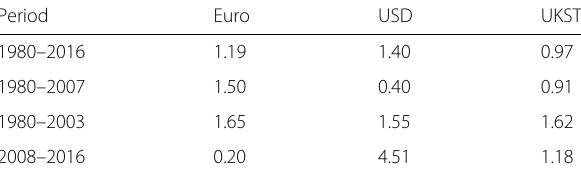
Table 4 Return differentials on equity portfolios in local currency Period